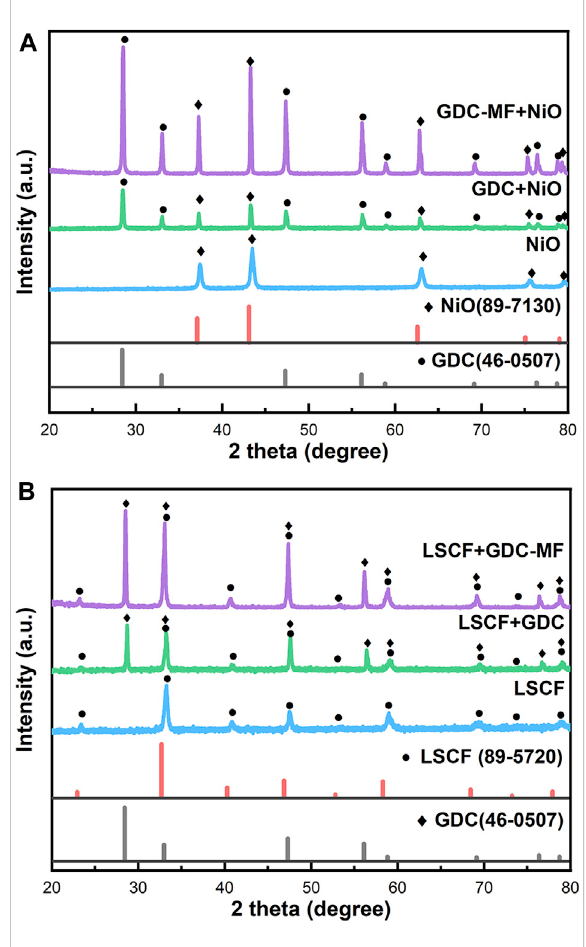
FIGURE 9 Chemical compatibility of the GDC-MF electrolyte with (A) LSCF cathode and (B) NiO anode